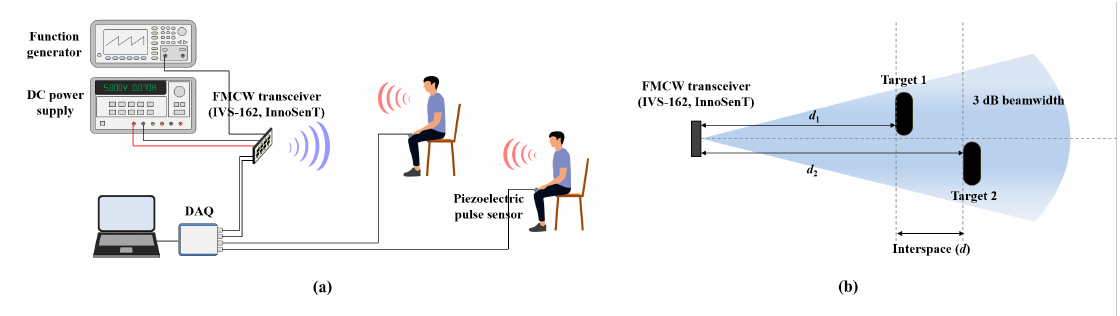
Figure 8. Experimental setup: ( a ) overview; and ( b ) top